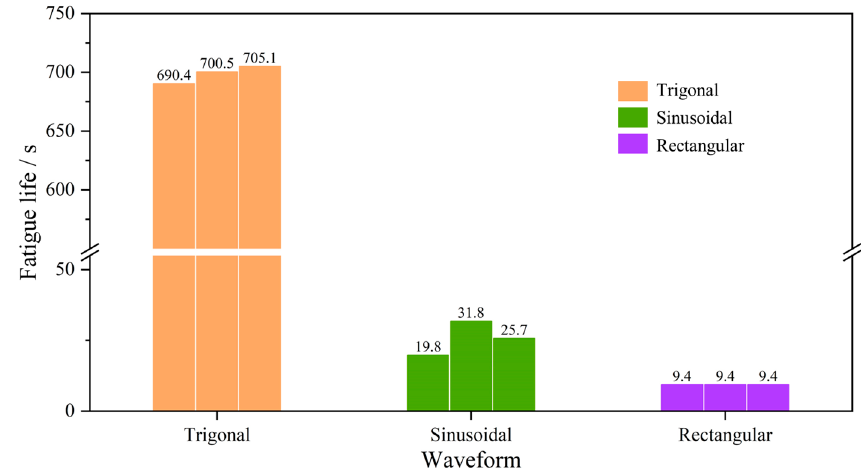
Figure 10. CPL fatigue lives of the YNS samples subjected di ff erent